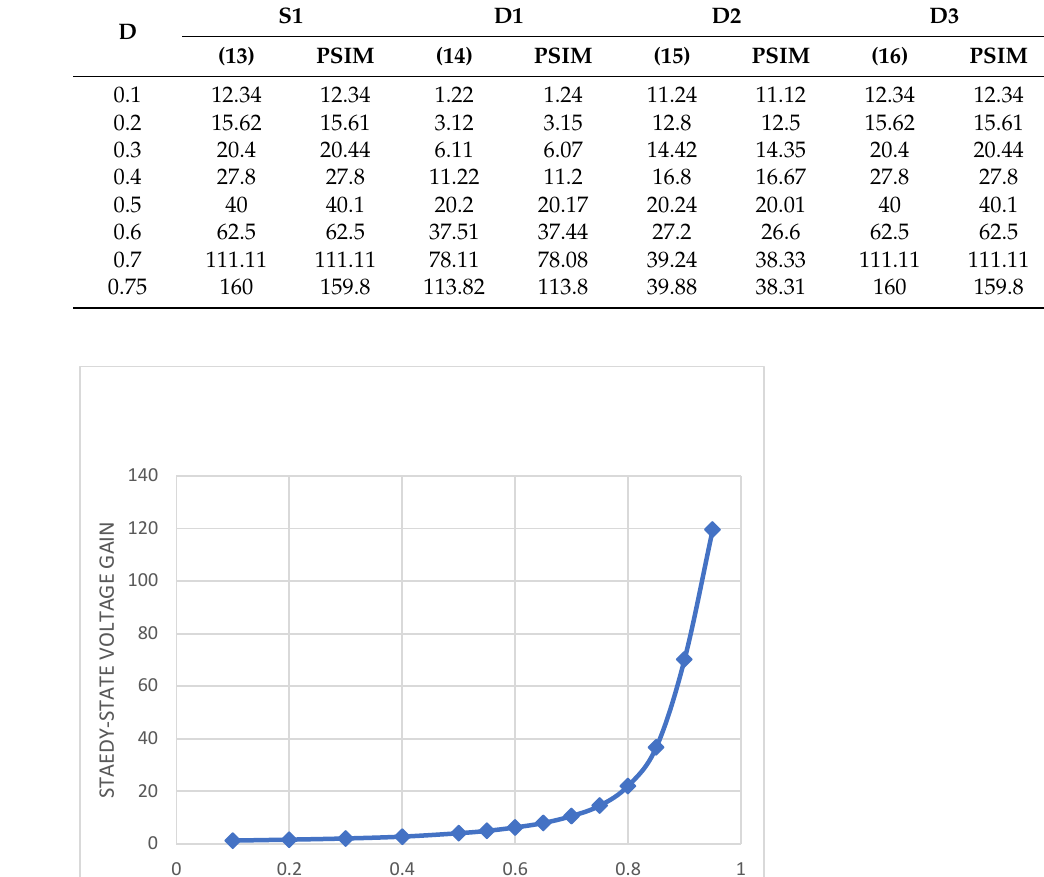
Table 1. Voltage stresses across different components at different duty-cycles.